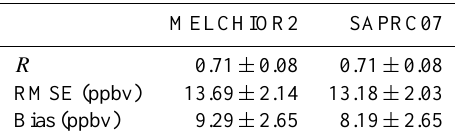
Table 4. Averaged values, with their standard deviation of the corre- lation coefficient, the root mean square error and the bias, calculated for the comparison of simulated ozone with EEA AirBase data over Europe for summer 2005, using MELCHIOR2 (left) and SAPRC07